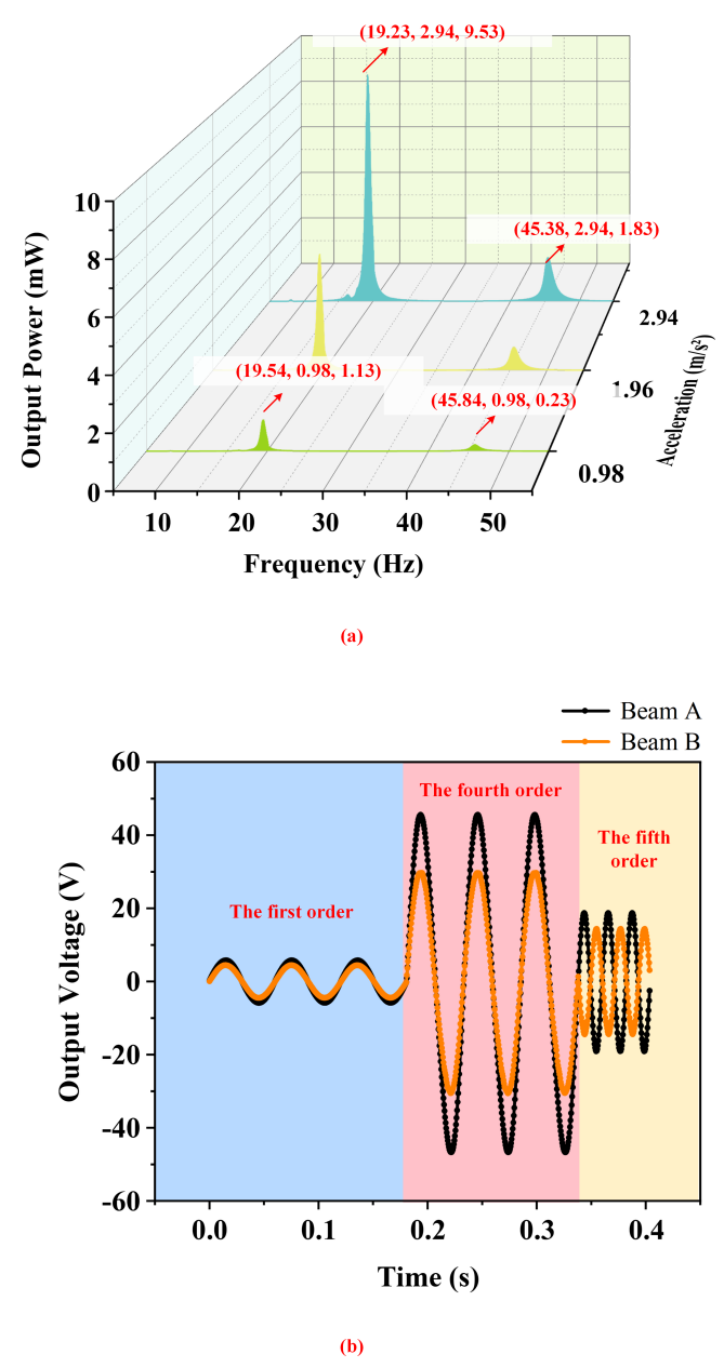
Figure 8. The output characteristics of the PEH under different accelerations by experiment. ( a ) The output power of the energy harvester under different accelerations; ( b ) the time − domain waveforms of beam M and beam W.